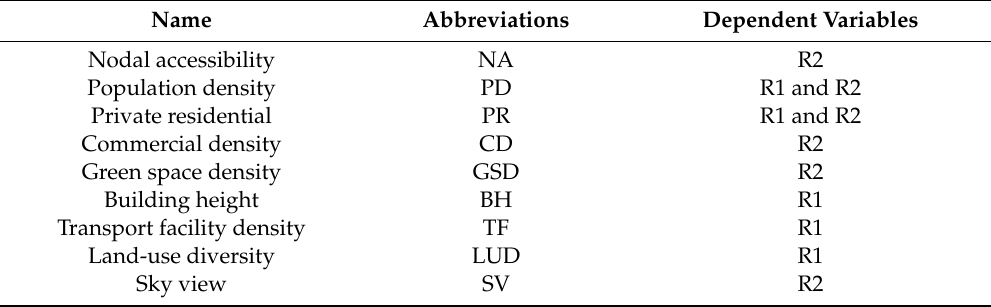
Table 1. Explanations of the abbreviations for the built-environment